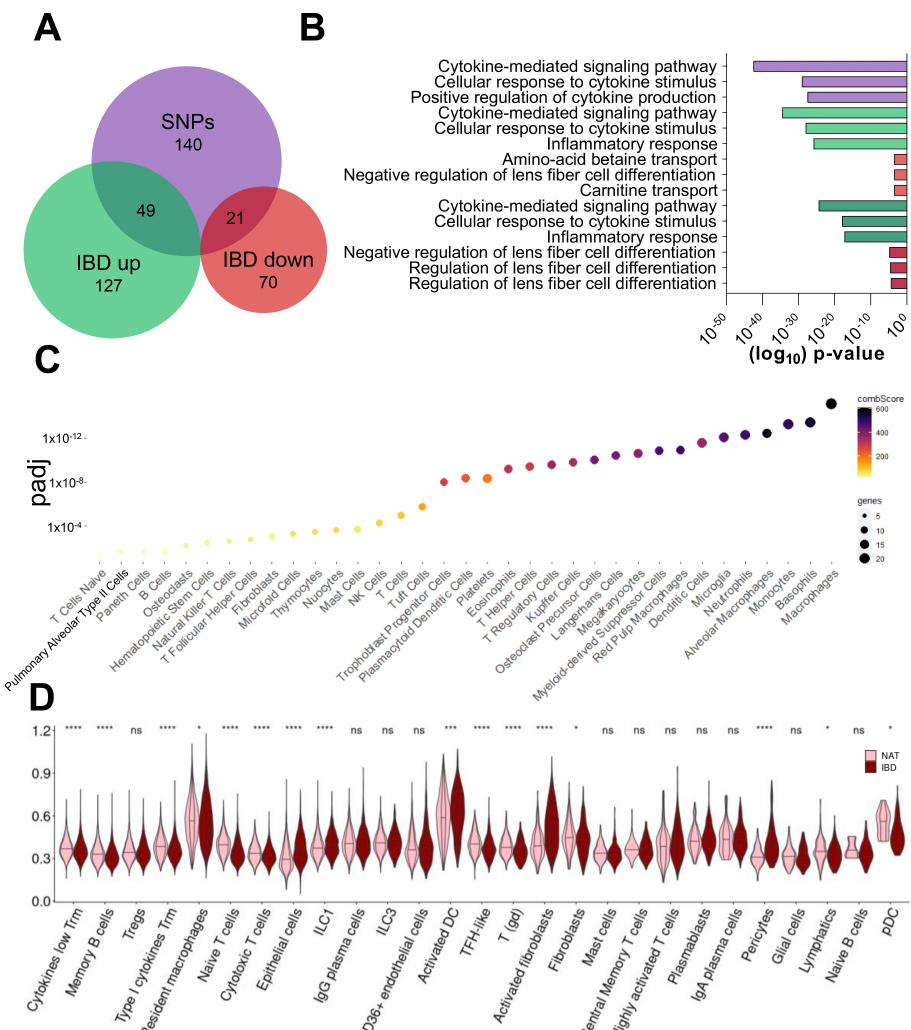
Figure 1. Identification of cell populations upregulating CD risk genes. ( A ) Venn diagram displaying SNP-containing loci linked to IBD [13,14] with genes up- or downregulated in CD [10]. ( B ) Gene ontology (GO Biological Process, EnrichR [16]) revealed that SNP-containing loci (purple), genes upregulated in CD (green) and their overlap (teal) are related to inflammatory pathways, while genes downregulated in CD (red) and their overlap with SNP-containing regions (dark red) are not. ( C ) Dot plot depicting cell types related to CD-induced genes according to PanglaoDB Augmented 2021 [17]. The dot color reflects a combination of p -value and z-score, referred to as combined score, whereas the dot size correlates to the number of enriched genes. ( D ) Violin plot indicating the pairwise enrichment of CD-induced genes in scRNA-seq data from CD lesions (IBD; dark red) and uninflamed control tissue (NAT; light pink; [15], Wilcoxon-test). * p < 0.05, *** p < 0.001, **** p <